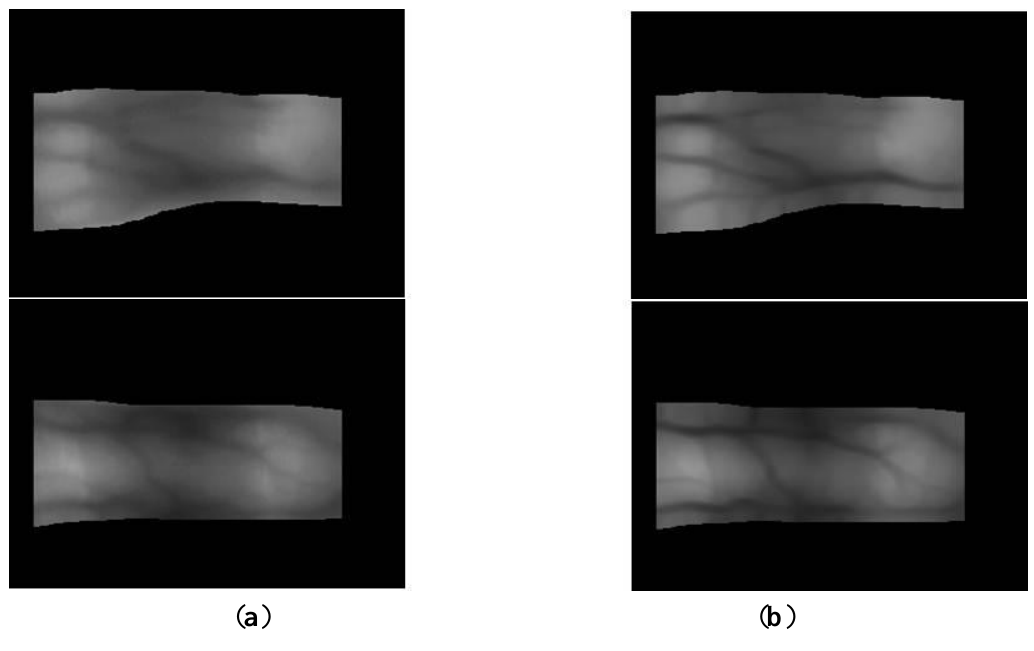
Figure 6. Examples of the results obtained by four-directional Gabor filtering using images from database II: ( a ) the original images with the detected finger boundaries; and ( b ) the images produced after the application of